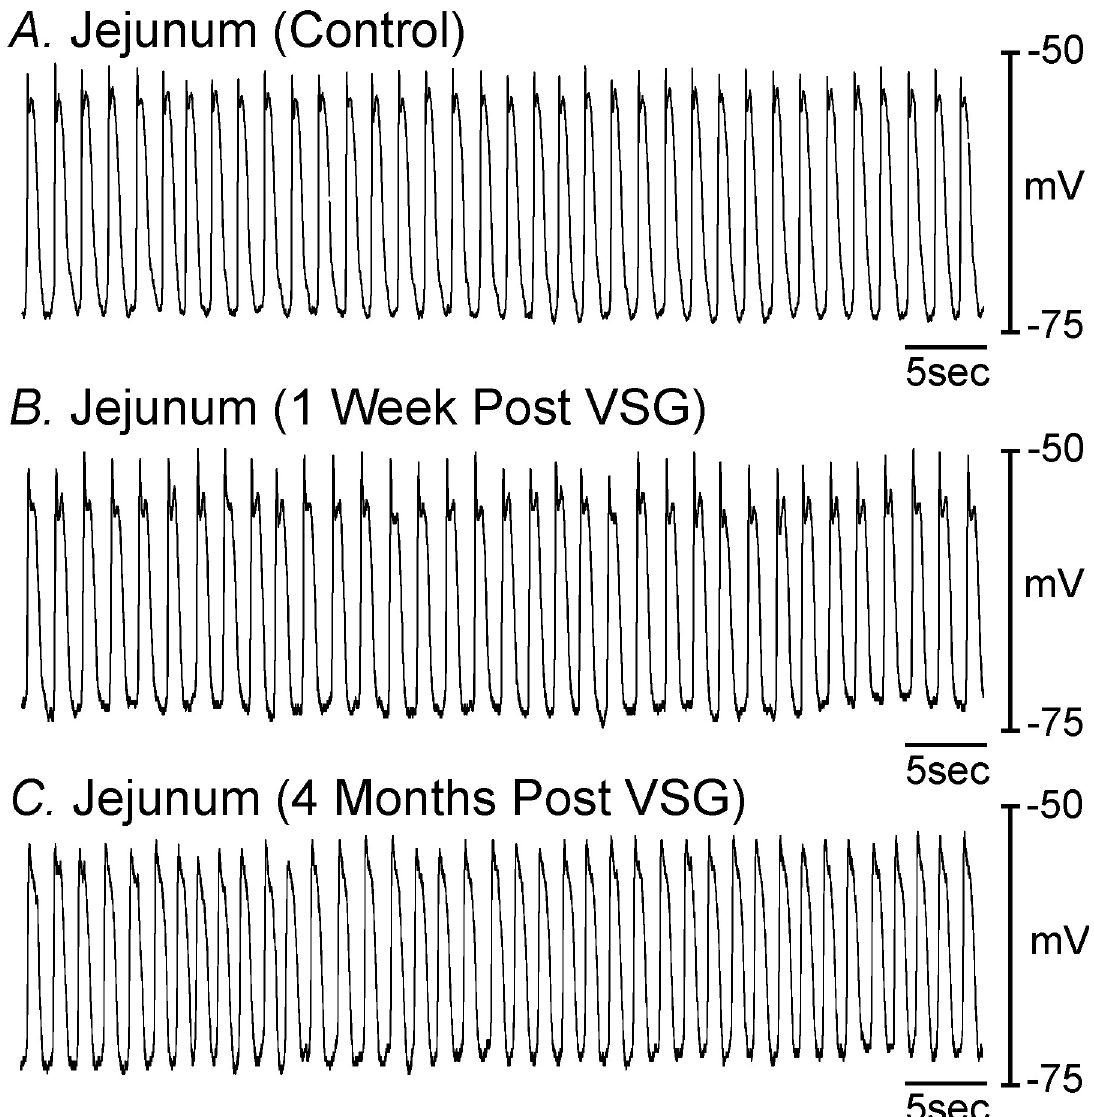
Fig 6. Loss or disruption of pacemaker activity was limited to the stomach. Panel A, Pacemaker activity recorded from the jejunum of a sham-operated animal and Panel B, 1-week post-VSG. Panel C, Jejunal slow waves 4-months following VSG. There was no difference in pacemaker activity recorded from jejunums post-VSG at any time period compared to controls (n = 4).